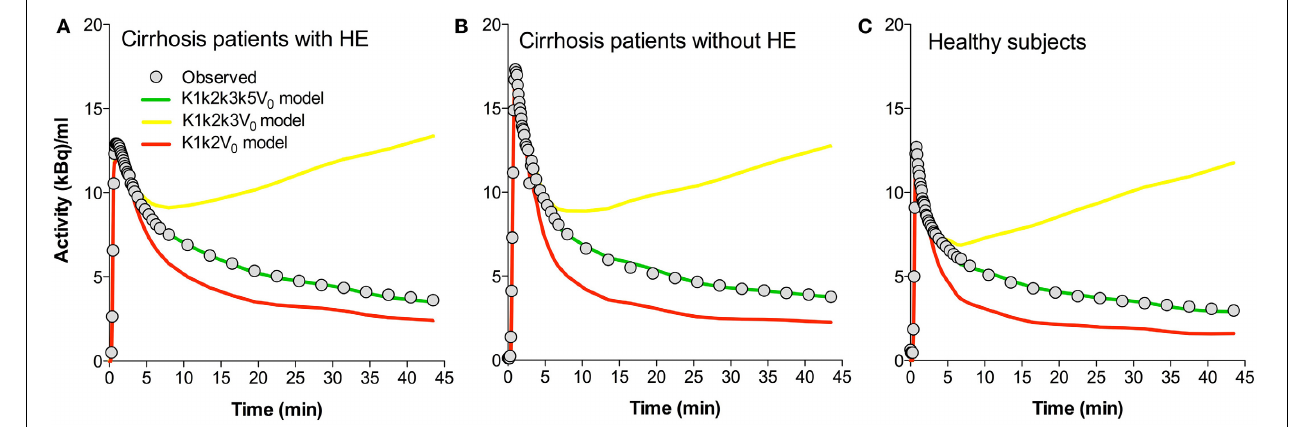
FIGURE 4 | Predicted time-activity curves for three whole-brain model configurations. (A) Average data sets for patients with cirrhosis and hepatic encephalopathy (HE). (B) Patients with cirrhosis without HE. (C) Healthy subjects. Each panel shows the observed values, the fitted values using a K 1 k 2 k 3 k 5 V 0 model (“full” model), and the predicted behaviors of the